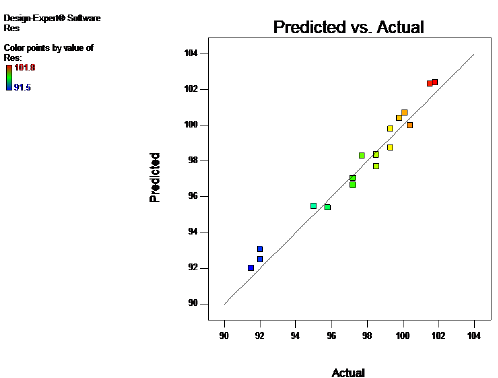
Figure 1. Comparisonbetween actual and calculated values of ON from linear model